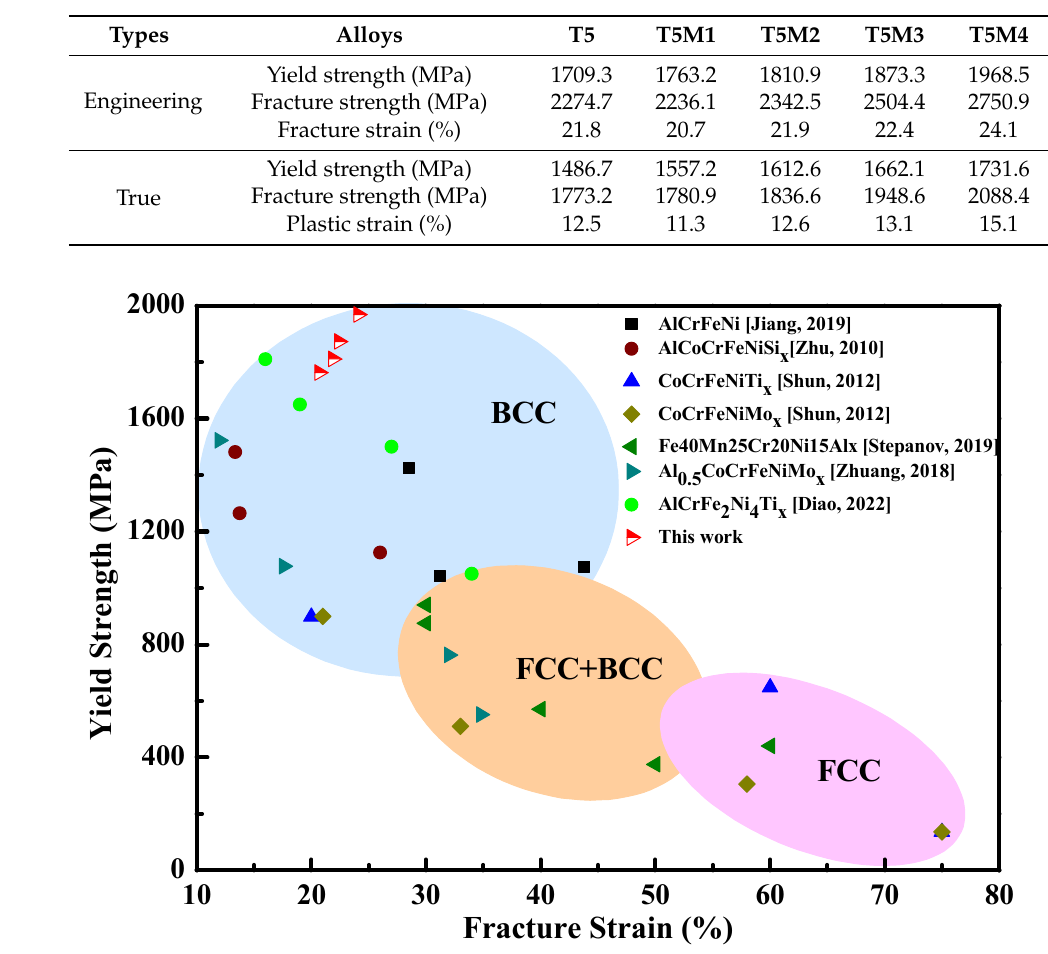
Figure 6. Property comparison between AlCrFeNiTi 0.5 Mo x and other HEAs reported in the litera-